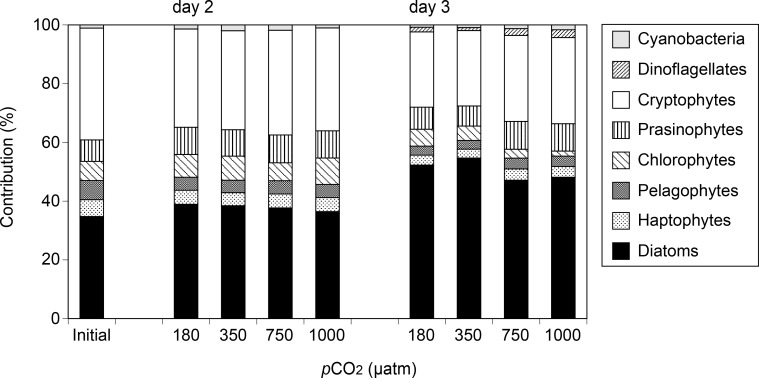
Mean contributions of each phytoplankton group to total Chl a biomass as estimated by CHEMTAX.Error bars denote ± 1 SD (n = 3).